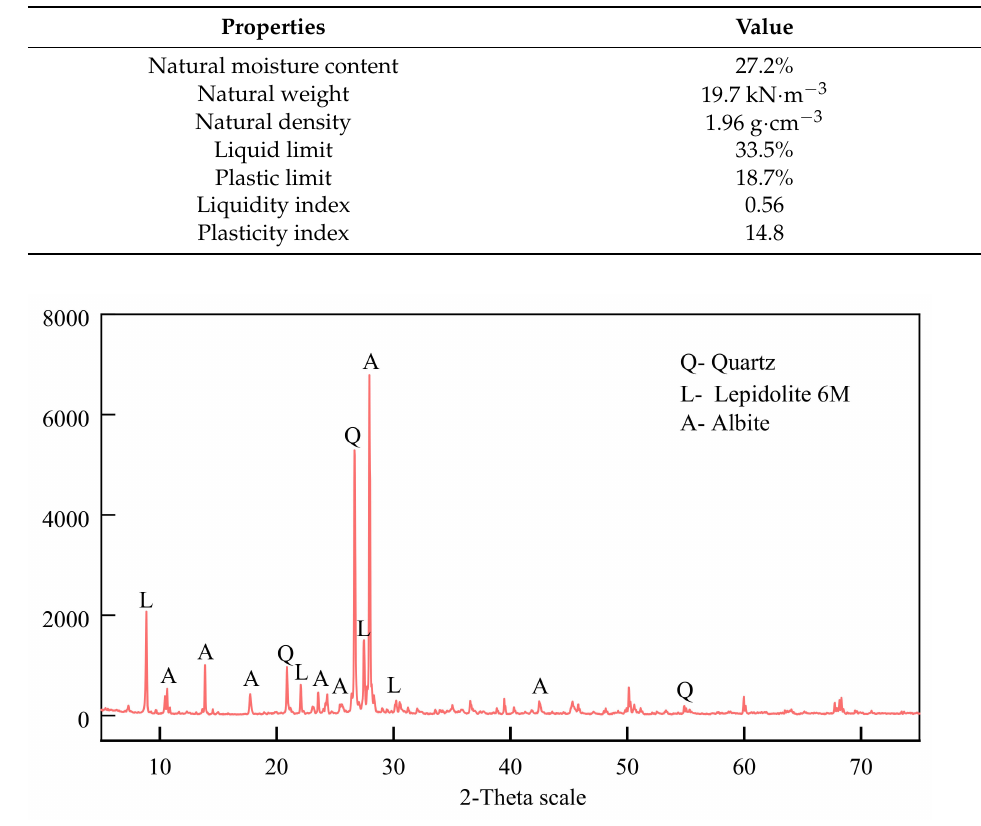
Figure 2. XRD pattern of